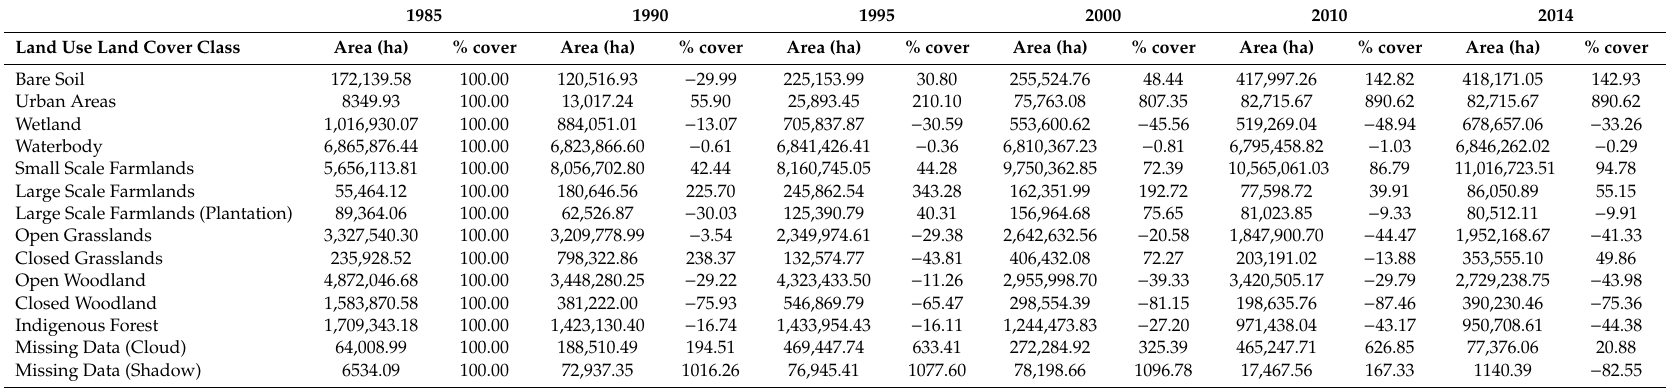
Table 2. Land cover area (ha) for each land cover type and the corresponding percentage change normalized using the 1985 hectarage as base area.